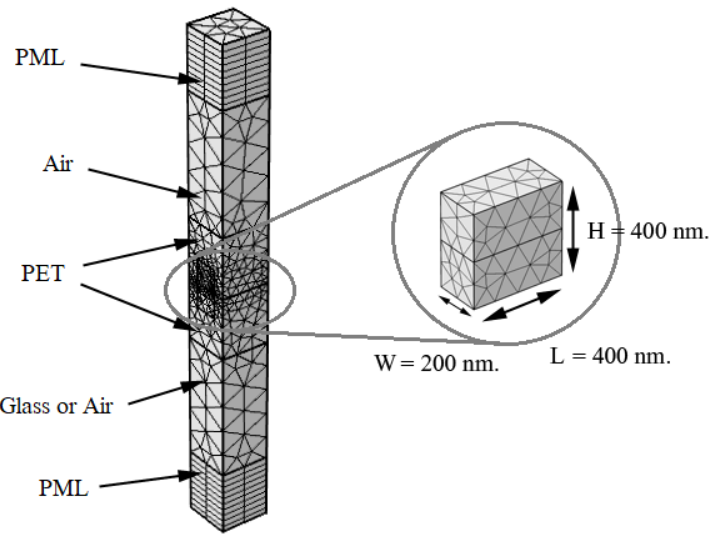
Figure 5. Meshing characteristics of the proposed film.